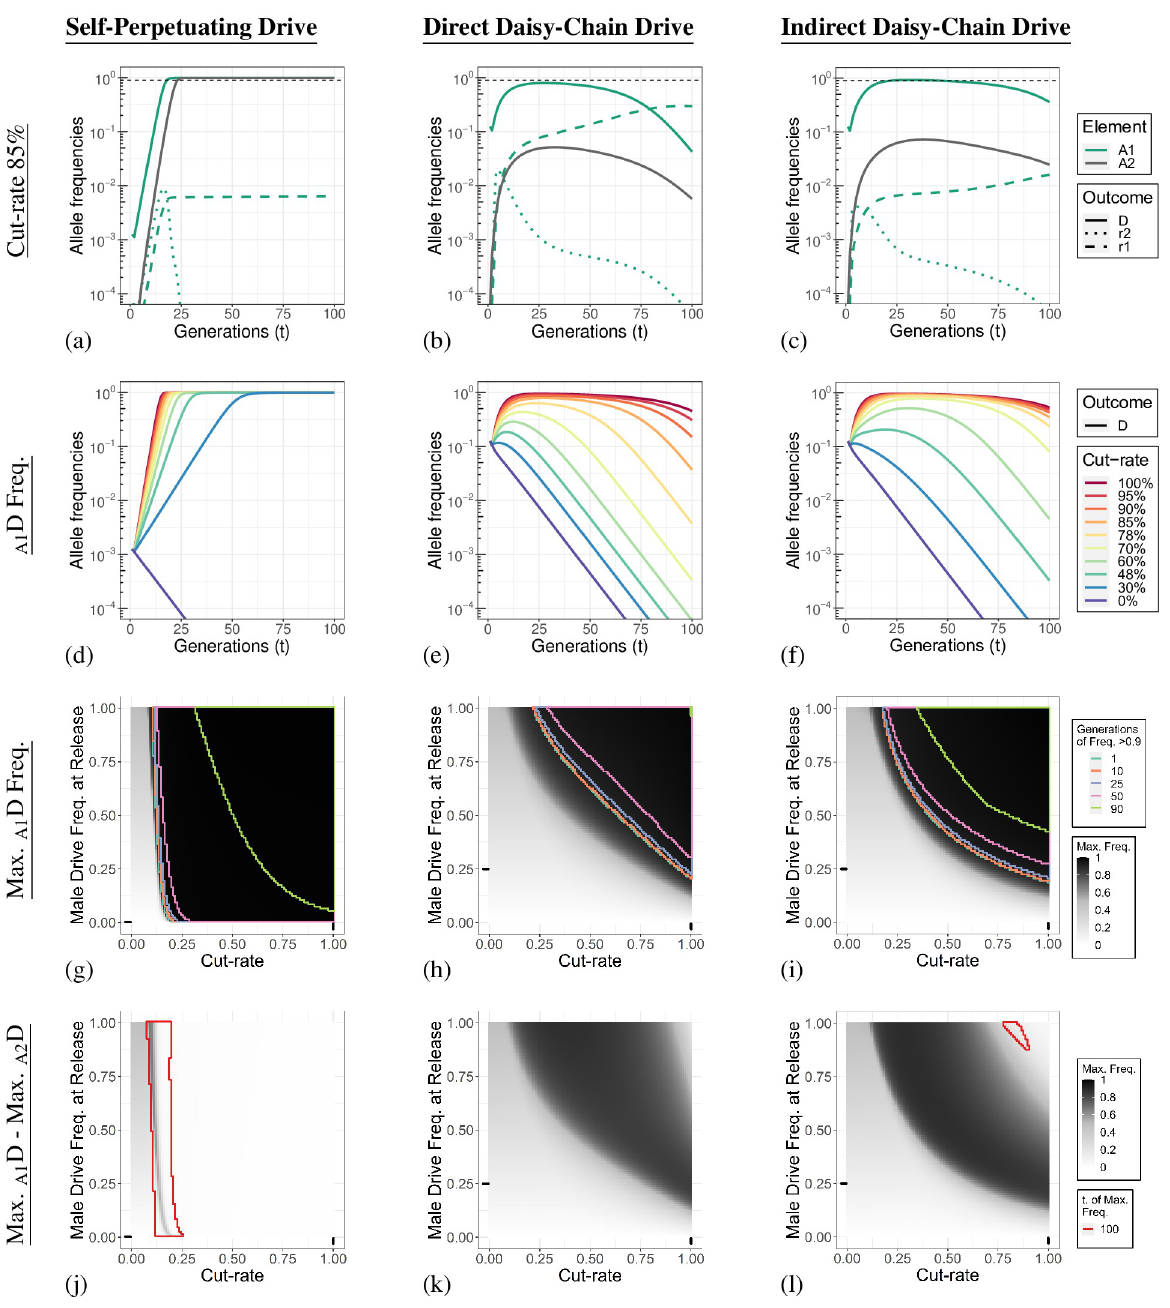
Fig 3. Daisy-chain gene drive element prematurely segregate with reduced cut-rates. Column 1 . Self-Perpetuating Drive. Column 2 . Direct Daisy-Chain Drive. Column 3 . Indirect Daisy-Chain Drive. Row 1 (a-c) . Individual allele dynamics with a cut-rate of 85%. The thin dashed line indicates a frequency of 90%. An allele at locus A in population one is indicated by A1 (green lines), and a drive allele at locus A in population two is indicated by A2 (gray line). Type 1 and 2 resistance alleles are not shown for population two in these panels. The allele dynamics for all loci are shown in S10 Fig. Row 2 (d-f) . A element drive allele dynamics for population one with different cut-rates. Allele dynamics of the A locus drive allele in population two, and type-1 resistance alleles for both populations are shown in S11 Fig. Row 3 (g-i) . Parameter sweep for the male drive frequency at release and germline cut-rate. The shading of the heat map indicates the maximum A D allele frequency in population one reached within the 100 generations simulated. The maximum frequency of A 1 alleles and outcomes for population two are shown in S13 Fig. An immediate decline after release results in the maximum frequency being the release frequency. Regions are boxed with coloured lines that indicate threshold values for the number of generations in which the A1 D allele frequency was greater than 90%. The black lines on each axis indicate the default value for the parameter being varied. Row 4 (j-l) . Difference in the maximum A D allele frequency between population one and two. Regions boxed with a red line are simulations in which the maximum allele frequency of population one or two was at generation 100 and the outcomes may change if additional generations are simulated.